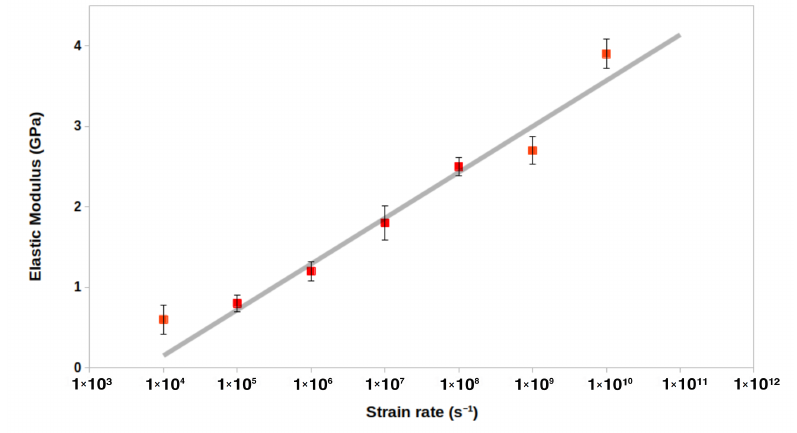
Figure 5. The elastic modulus (4) of the pure PP system with 50 monomers per chain (10 × 10 × 10 nm 3 unit cell) shown as a function of the strain rate. Regression fit for strain rates in the range 1.0 × 10 5 to 1.0 × 10 8 s − 1 is shown. The strain rate along the x -axis is plotted on a logarithmic scale.